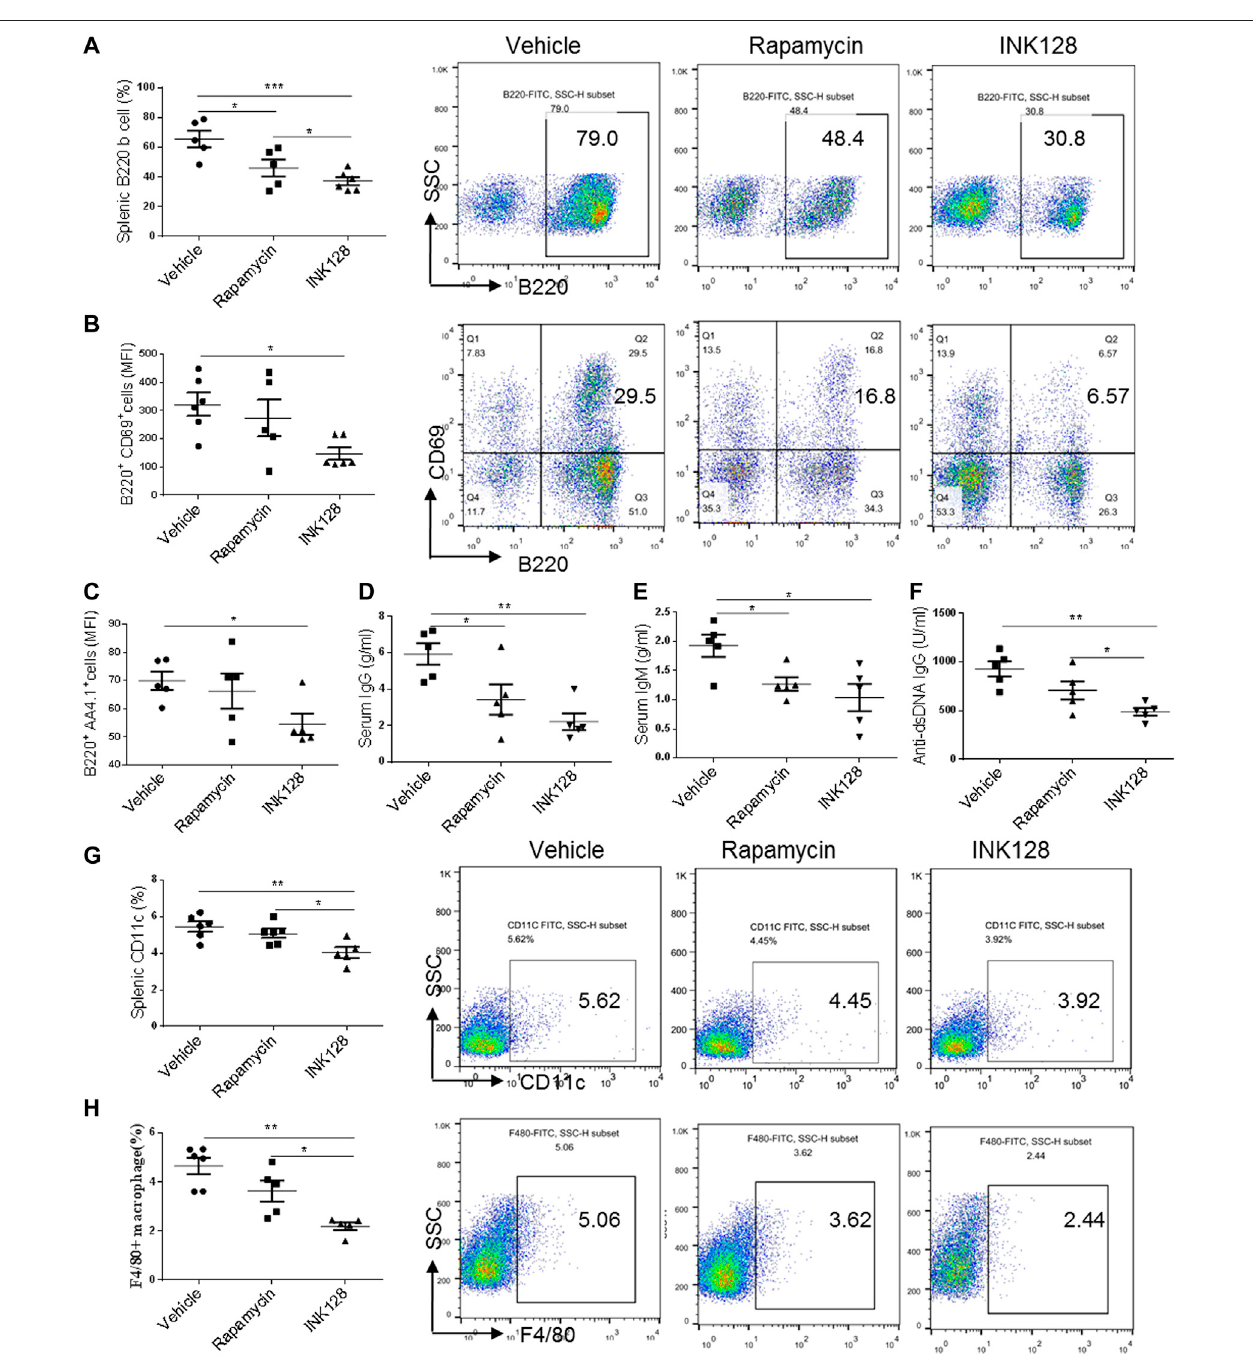
FIGURE 2 | INK128 reduces concentrations of auto-antibodies and inhibits activation of B cells. (A) The percentage of B220 + B cells in spleens were analyzed by fl ow cytometry. Data are representative or are the median ± interquartile range from fi ve or six independent experiments with one independent mice per group in each experiment. (B) ThesurfaceexpressionofCD69inB220 + Bcellsinthespleenswereanalyzedby fl owcytometry.Dataarerepresentativeorarethemedian ± interquartile rangefrom fi veorsixindependentexperimentswithoneindependentmicepergroupineachexperiment. (C) ThesurfaceexpressionofB220 + AA4.1 + Bcellsinthe spleenswereanalyzed by fl owcytometry. Dataarerepresentativeorarethemedian ± interquartile rangefrom fi veor sixindependentexperiments withoneindependent mice per group in each experiment. (D – F) Serum levels of total IgG, IgM and anti-dsDNA IgG were determined by ELISA. Data are representative or are the median ± interquartile range from fi ve independent experiments with one or two independent mice per group in each experiment. (G,H) The percentage of CD11c + DC cells (G) and F4/80 + macrophage cells (H) in spleens was analyzed by fl ow cytometry. Data are representative or are the median ± interquartile range from fi ve independent experiments with one or two independent mice per group in each experiment. Data was analyzed by the non-parametric Mann-Whitney U-test. (* p ≤ 0.05, ** p ≤ 0.01, *** p ≤ 0.001). Immunomodulatory effects of INK128 treatment on T cell populations in MRL/lpr mice.